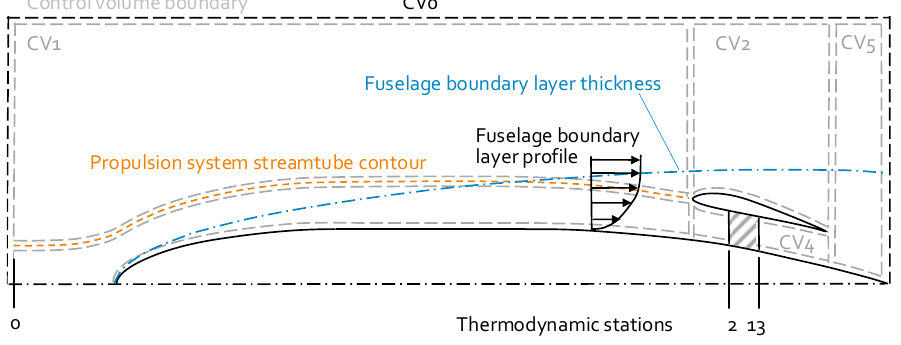
Figure 5. Control volume scheme for bare PFC bookkeeping (adapted from [45]).